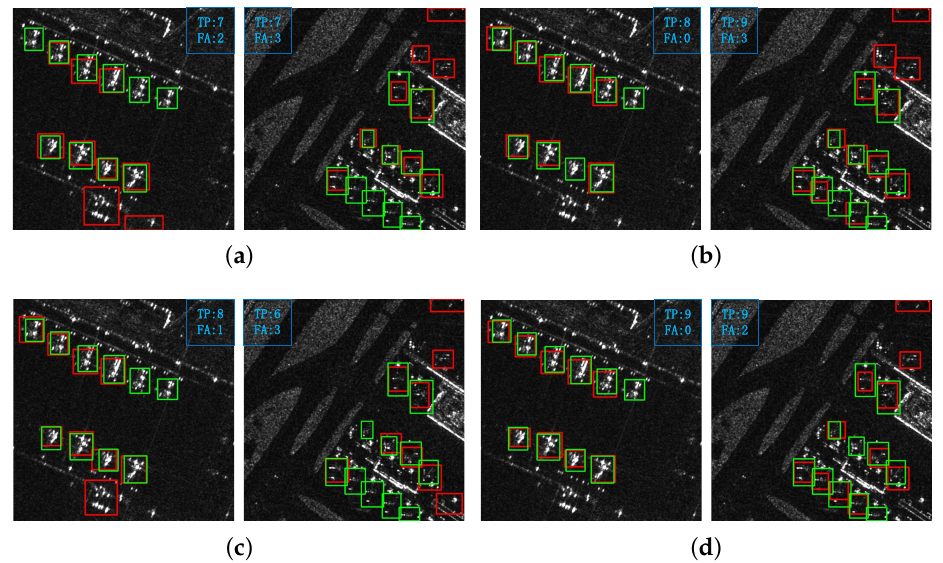
Figure 13. The detection results reported in Table 5. The red boxes represent the detection results and the green boxes represent the ground truth. We count the evaluation results in blue boxes. TP means accurately predicted targets and FA means false alarms. ( a ) +SE [34]. ( b ) +CBAM [30]. ( c ) +ECA [35]. ( d )